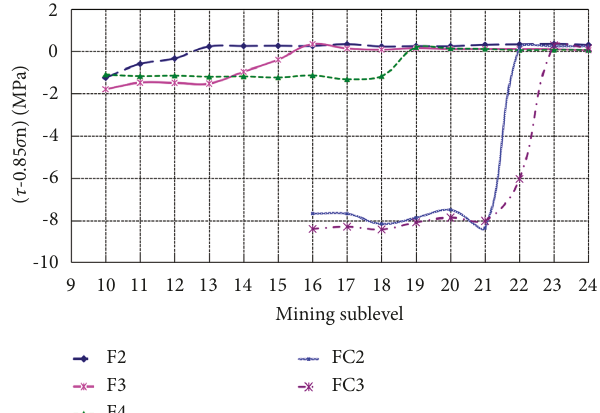
Figure 25: Temporal and spatial relationship curve of fault FC2 and FC3 values changing with mining